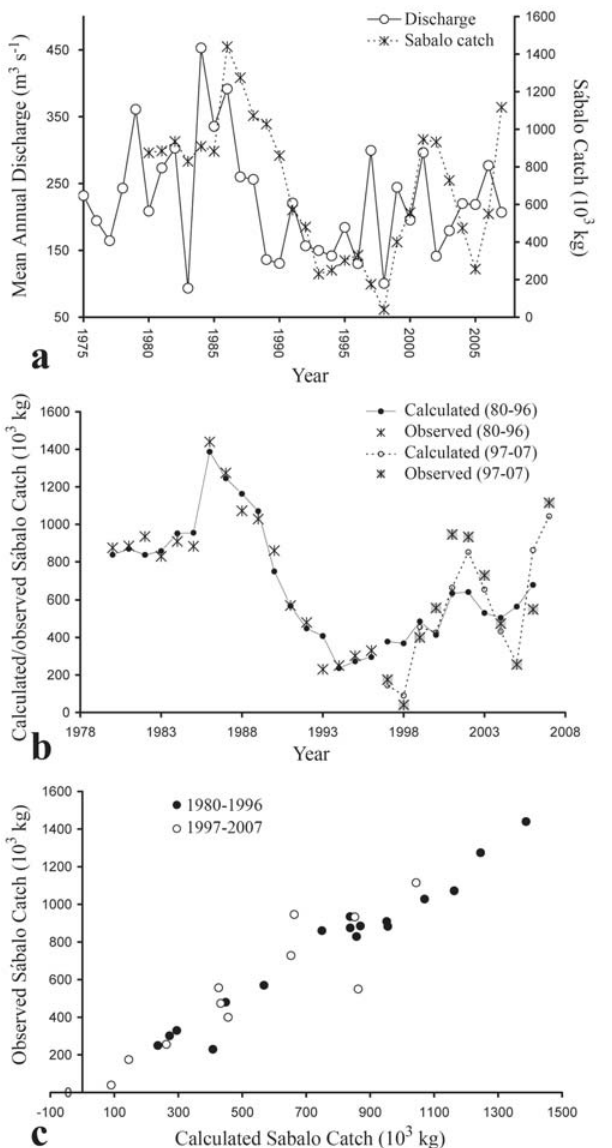
Fig. 5. (a) Mean annual discharge and Sábalo catches over the years in the Pilcomayo River near Villa Montes. (b) Calculated and observed Sábalo catches based on the data presented in Fig. 4a. Correlations were obtained by stepwise multiple linear regression with backward selection (SPSS v. 15.0). The river discharge of the seven preceding years (Y1-Y7) plus the current year (Y0) were used in the analyses. The solid line is based upon the years 1980-2006. The dashed line is based upon the years 1997-2007. (c) Observed Sábalo catches plotted against the calculated Sábalo catches for the years 1980-1996 and 1997- 2006. Data of Sábalo catches and mean river discharges were obtained from Proyecto Pilcomayo (Tarija,